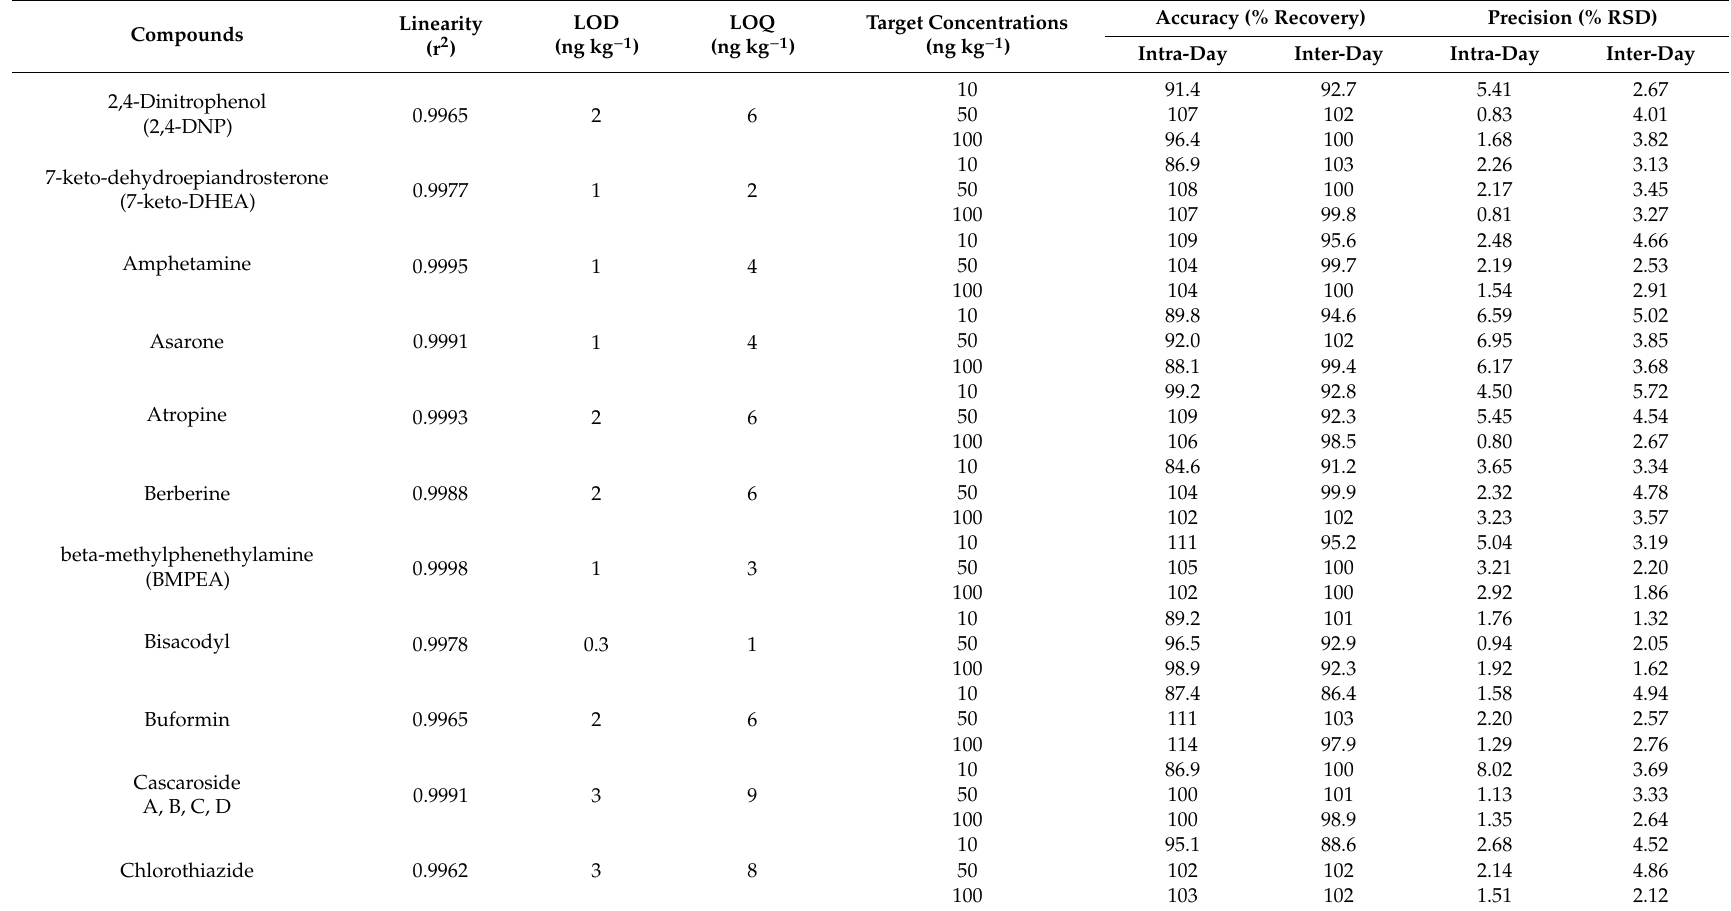
Table 2. LOQ, accuracy, and precision at three target levels in dietary